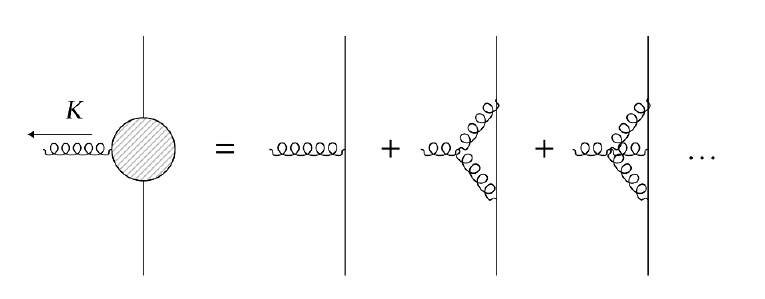
Figure 4 . The matrix element of the stress-energy tensor h T (cid:22)(cid:23) ( K ) i corresponds to the 3 point function associated to a pair of massive particles and an external o(cid:11)-shell graviton. The coupling to internal gravitons emanating from the massive source yields, in the long-range behavior, higher corrections in G